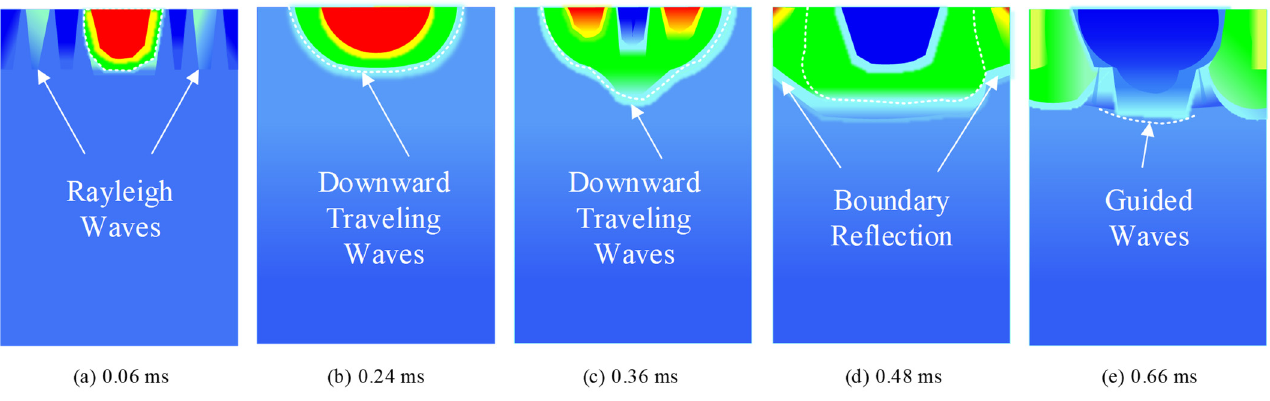
Figure 10. Formation of the high-frequency interference caused by radial transverse wave (repro- duced from Meng and Su (2022) [81]).